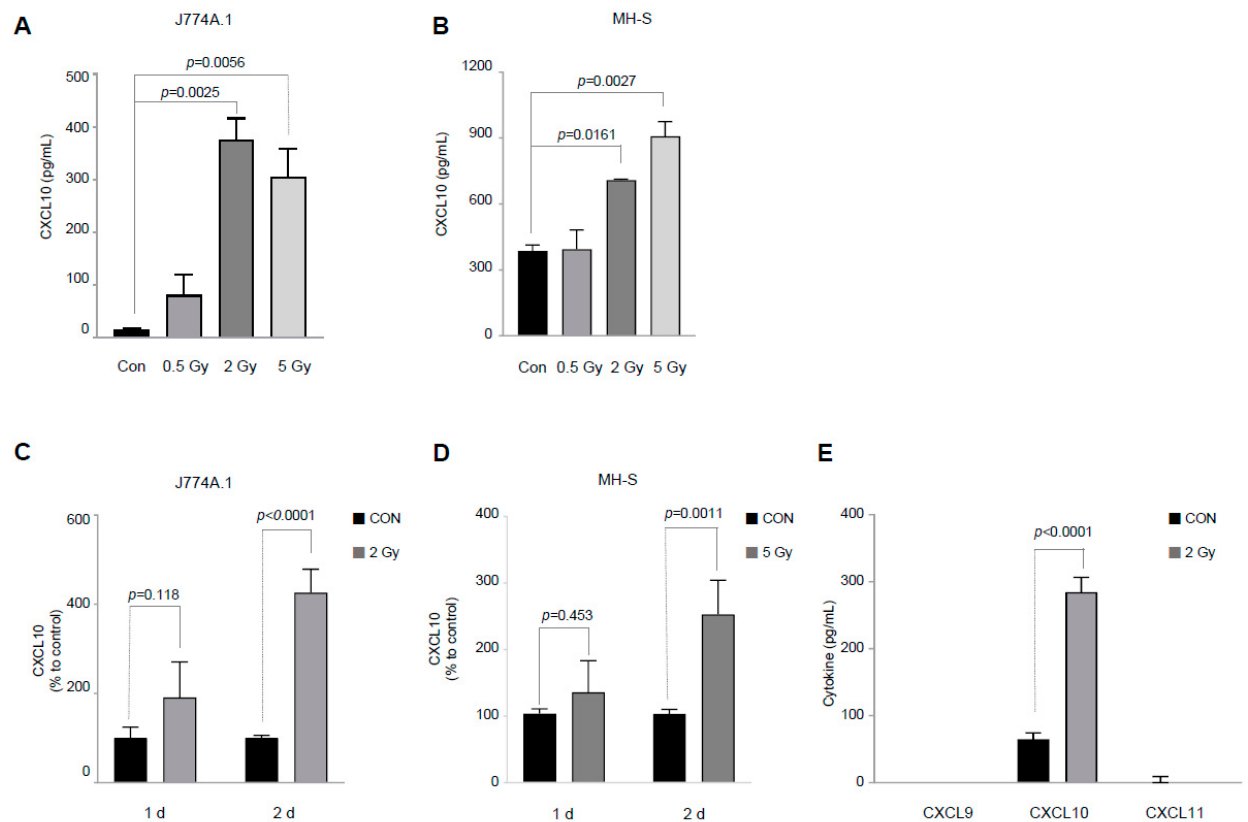
Figure 1. Ionizing radiation induces CXC ligand 10 (CXCL10) production in both the J774A.1 macrophage and MH-S macrophage cell lines. ( A , B ) Forty-eight hours after exposure to ionizing radiation at the indicated dose for the the 2 × 10 5 cells/mL of J774A.1 ( A ) and MH-S ( B ) murine macrophage cell lines, the amount of CXCL10 released into the cell culture medium was measured (n = 3–4). ( C , D ) After the J774A.1 ( C ) and MH-S ( D ) macrophages were irradiated with 2 Gy and 5 Gy, respectively, changes in CXCL10 production were observed over time. To compare the relative increase in CXCL10 production, it was expressed as relative production levels compared to each control group (n = 5–7). ( E ) The amounts of CXCL9, CXCL10, and CXCL11 released into the cell culture medium were measured 48 h after the J774A.1 macrophage cell line at 2 × 10 5 cells/mL was exposed to 2 Gy of radiation (n = 3). Bar graphs are presented as the mean ± standard error of the mean value.